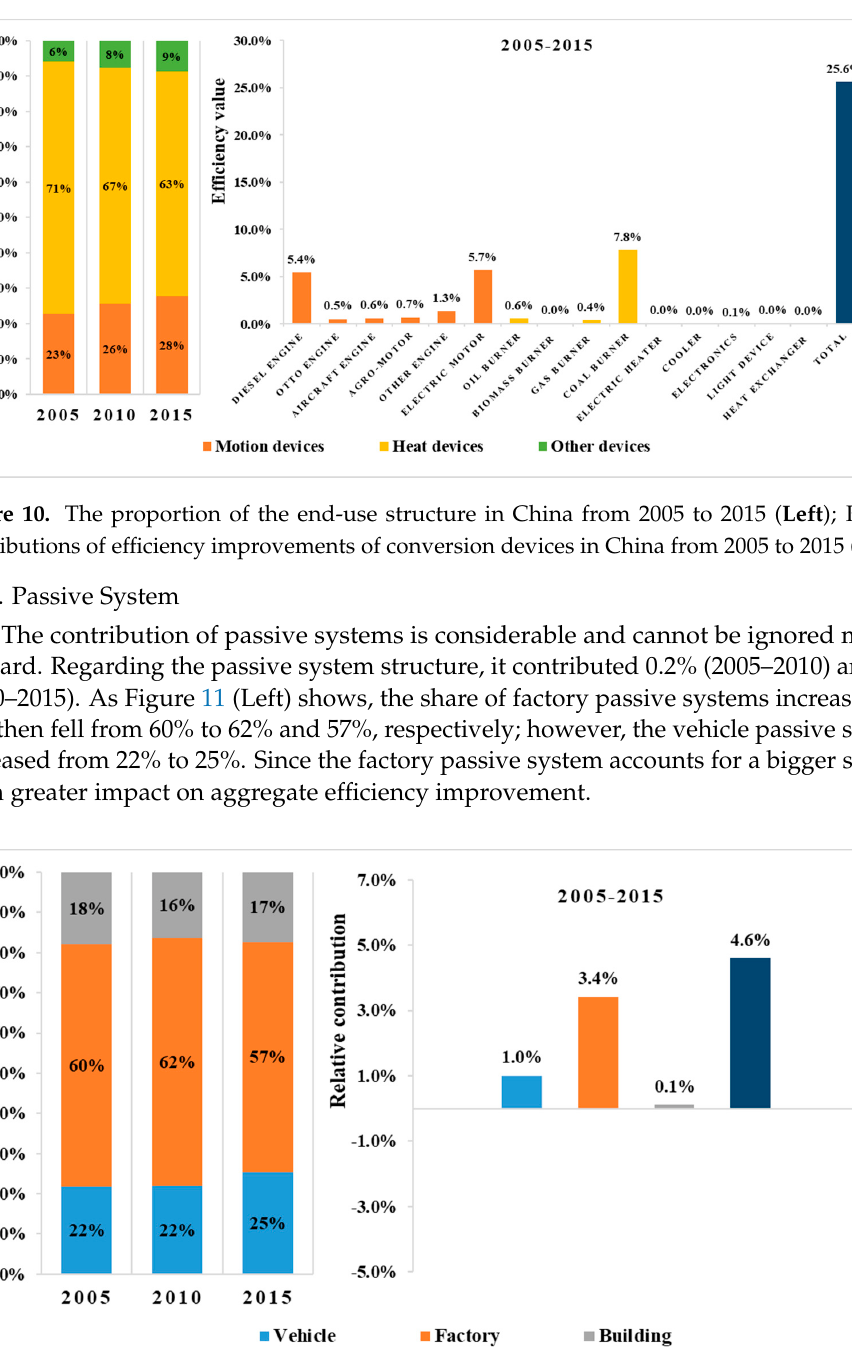
Figure 9. The efficiency of different power and heat generation sub-sectors in China from 2005 to 2015 (Left); Relative contributions of efficiency improvements in the power and heat generation sector in China from 2005 to 2015 (Right).